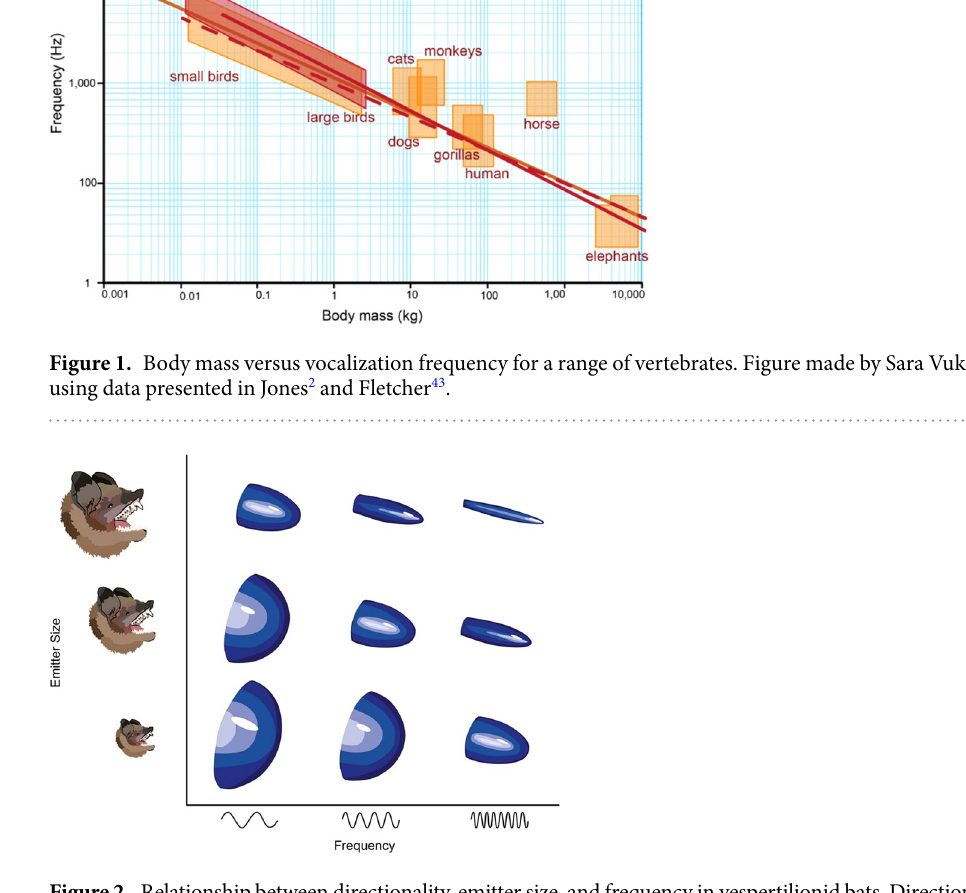
Figure 2. Relationship between directionality, emitter size, and frequency in vespertilionid bats. Directionality of the biosonar beam increases with emitter size and frequency. Figure remade by Sara Vukson from Jakobsen et al . 8 .